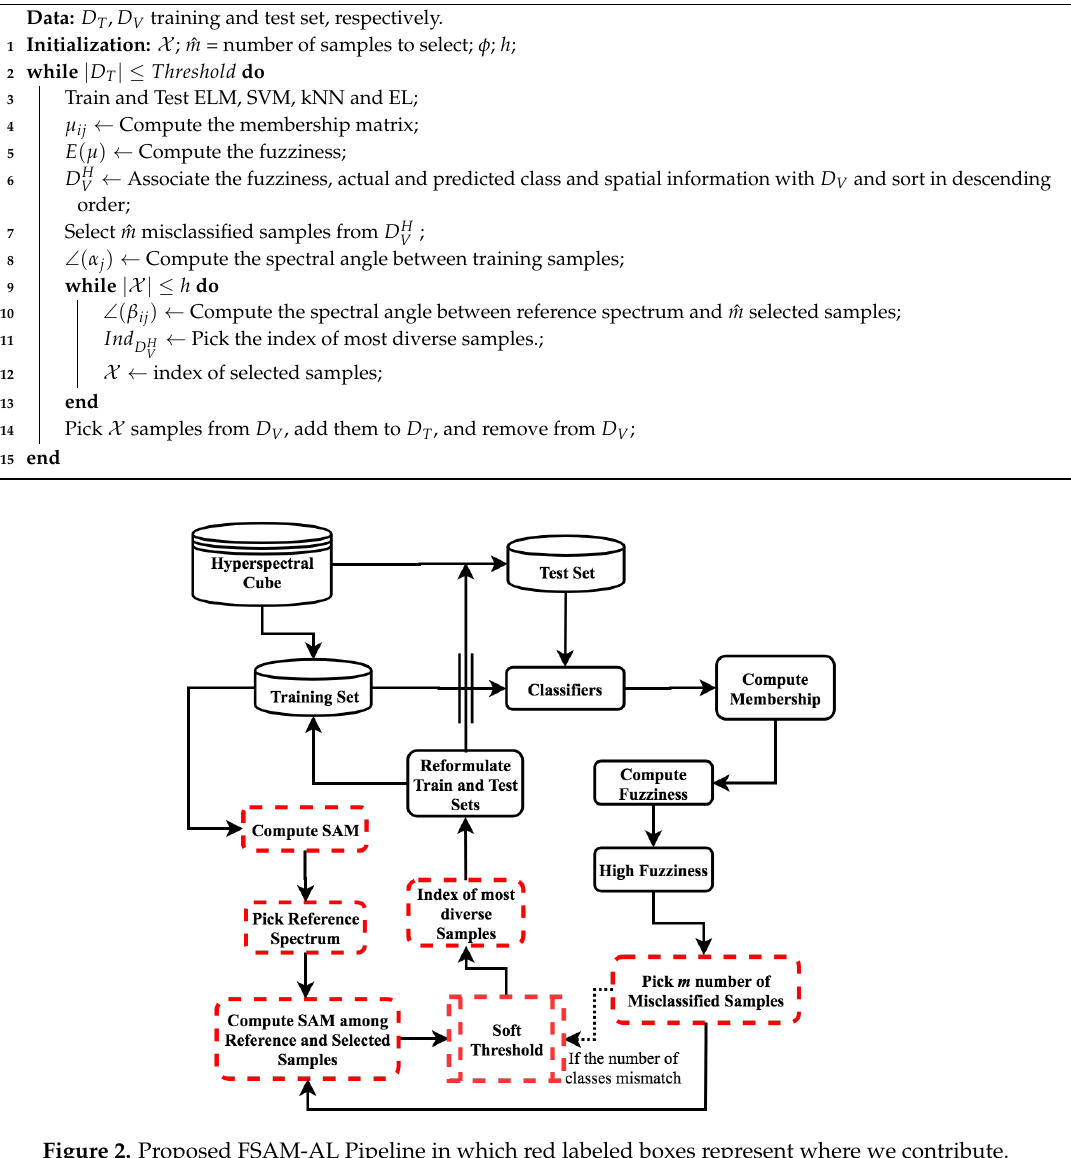
Algorithm 1: Pseudo-code of our Proposed FSAM Algorithm.